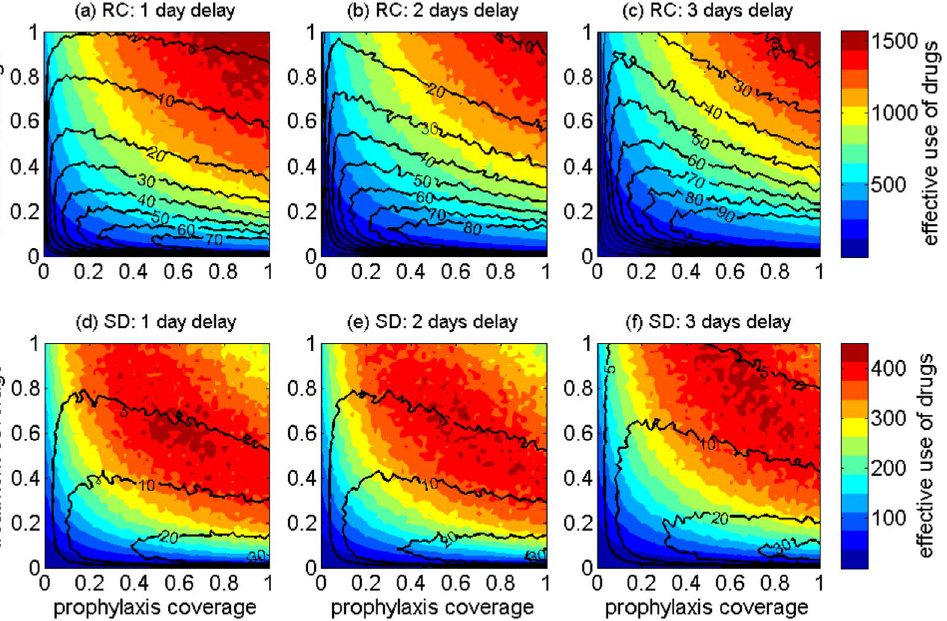
Figure 5. Box plots for the projected attack rates in households, workplaces, schools, and other places for RC and SD demographics with 1 day delay in start of treatment and a 3-week prophylaxis strategy. Red circles are outliers for boxplots between the first and third quartiles.